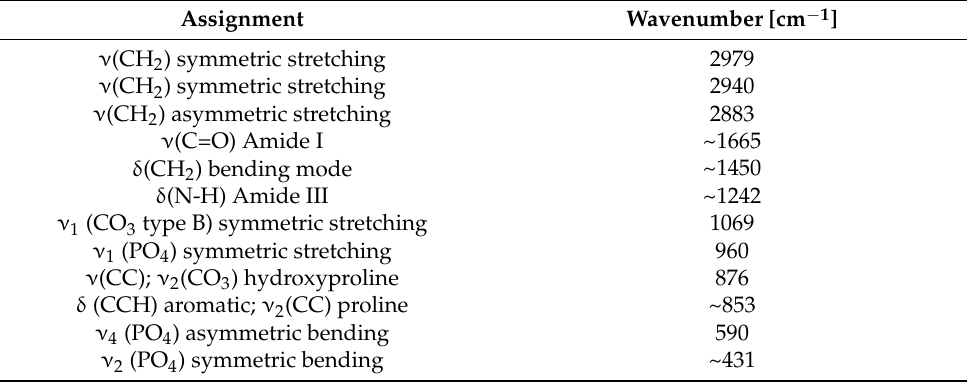
Table 1. Assignment of major bands found in Raman spectra of teeth